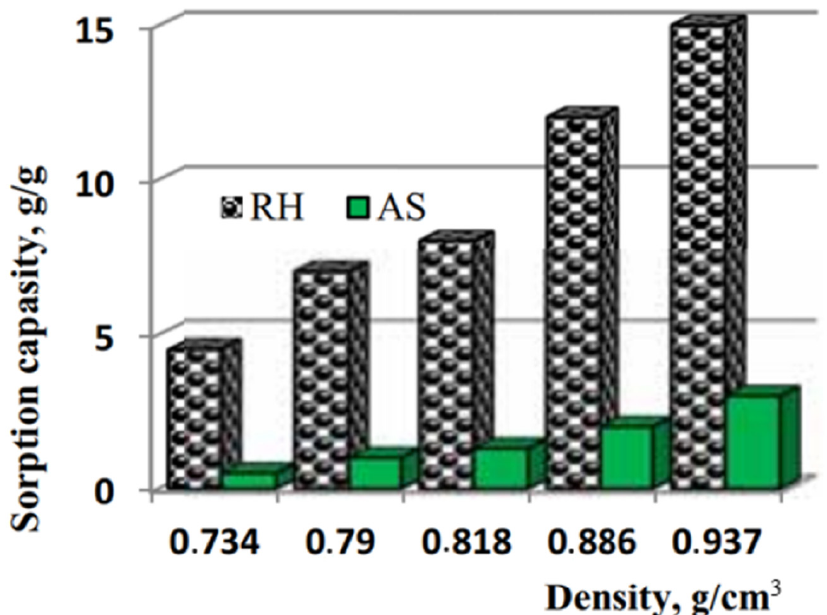
Figure 3. Sorption characteristics of carbonized rice husk and carbonized apricot stone as a function of petroleum product density. Reprinted with permission from Ref. [22]. Copyright 2014, Ministry of Education and Science of the Republic of Kazakhstan .